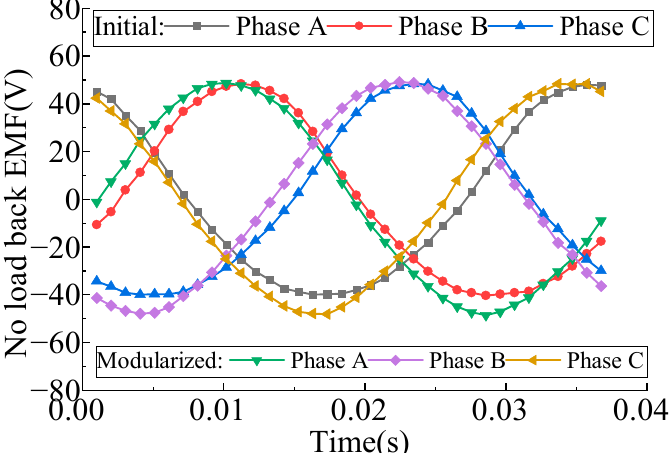
Figure 5. The waveform of no-load back EMF.